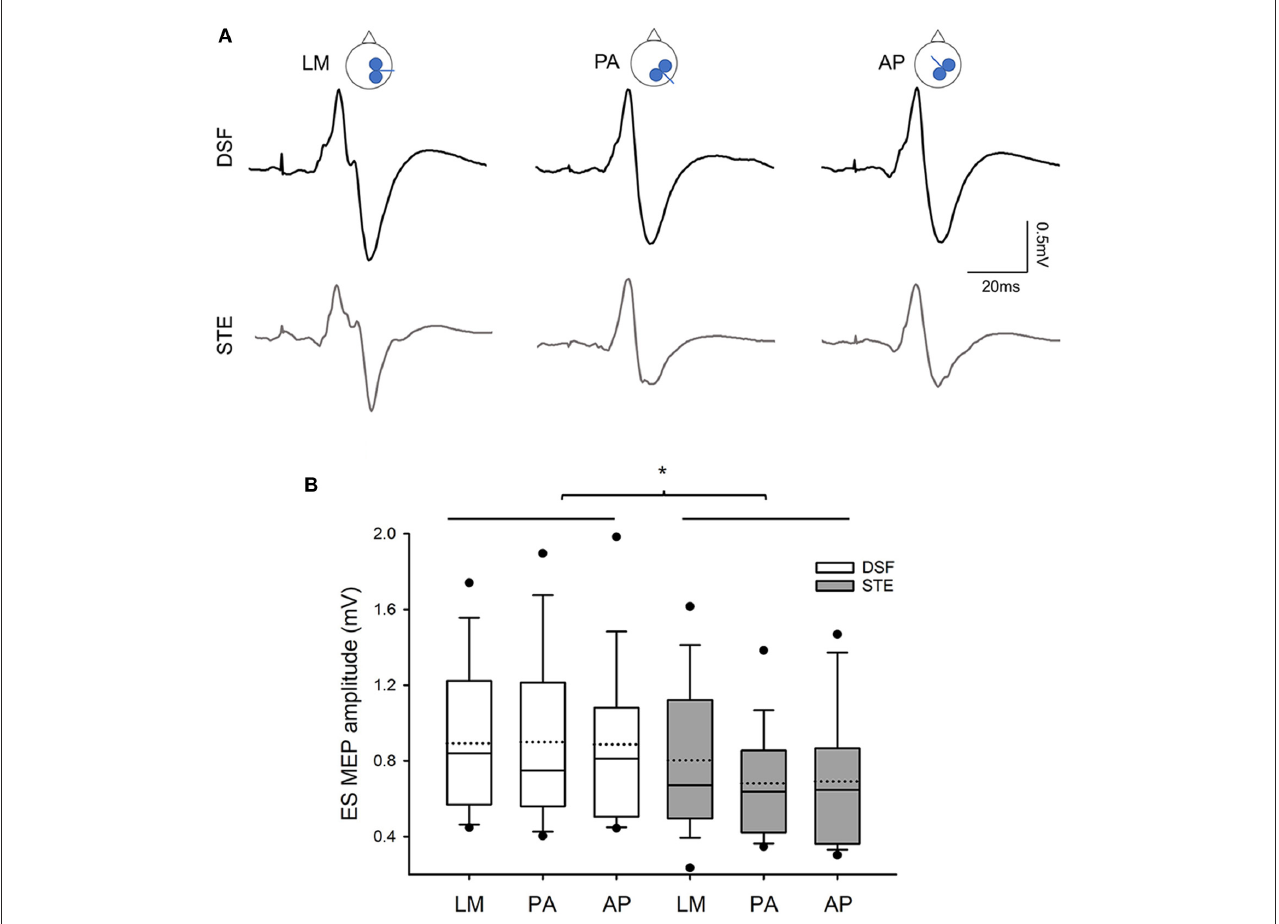
FIGURE4 MEP amplitudes (A) Averaged MEPs from 15 raw EMG traces in the contralateral ES muscle elicited by different coil orientations during the DSF and STE tasks in a representative participants. Note that MEP amplitudes are greater during the DSF task than during the STE task in all three coil orientations. (B) Group data ( n = 20) showing amplitudes of ES MEPs in three coil orientations during the DSF and STE tasks. Solid lines indicate median values; dotted lines indicate mean values. The box is interquartile range; error bars denote maximum and minimum values. * p < 0.05 between